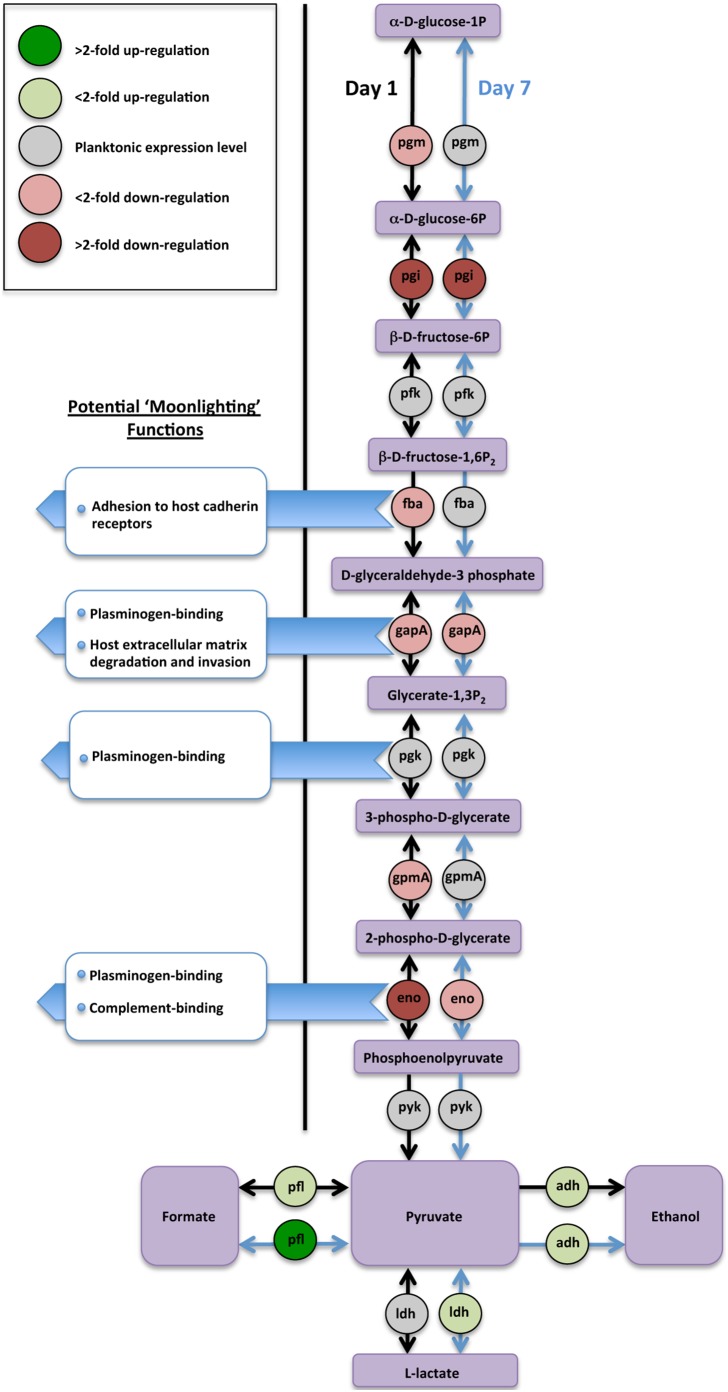
Change in expression of enzymes involved in the glycolysis/gluconeogenesis pathway and pyruvate metabolism of S. pneumoniae serotype 14 during biofilm formation.Based on iTRAQ expression data comparing mid-exponential planktonic cultures to day 1 and 7 biofilms. Proteins with potential moonlighting capability highlighted with their putative alternative functions. Pgm - phosphoglucomutase; pgi – glucose-6-phosphate isomerase; pfk–6-phosphofructokinase; fba – fructose biphosphate aldolase; gapA – glyceraldehyde-3-phosphate dehydrogenase; pgk – phosphoglycerate kinase; gpmA – phosphoglyceromutase; eno – enolase; pyk – pyruvate kinase, ldh – lactate dehydrogenase; adh – alcohol dehydrogenase, pfl – formate acetyltransferase.